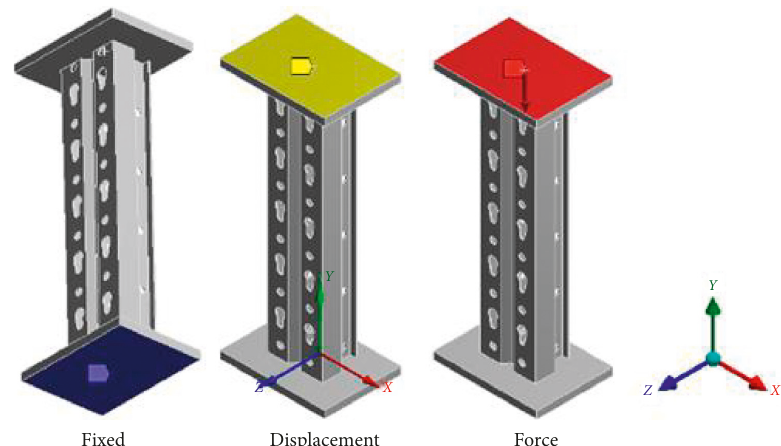
Figure 9: Constraint and load setting of the FE model on stub column.